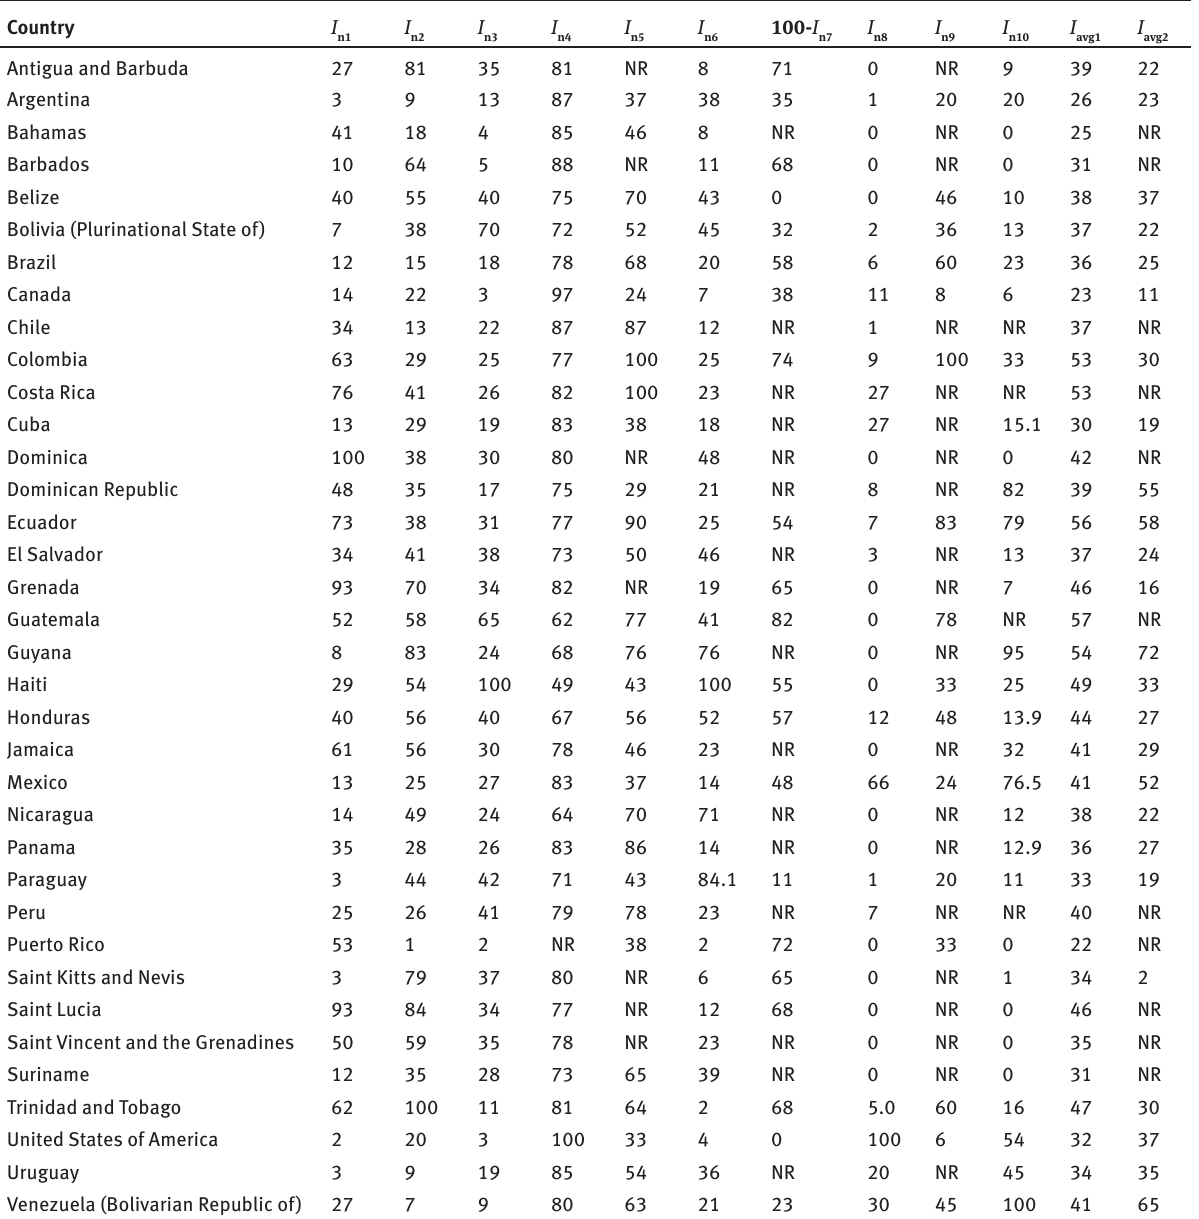
Table 4: Total conditions of the countries for agricultural water management based on the Eqs. 15 and 16, the desirability more than 50% shows a suitable status, the desirability between 30% and 50% shows a fairly status, and the desirability less than 30% shows a difficult status for agricultural water management (NR: Not Reported)